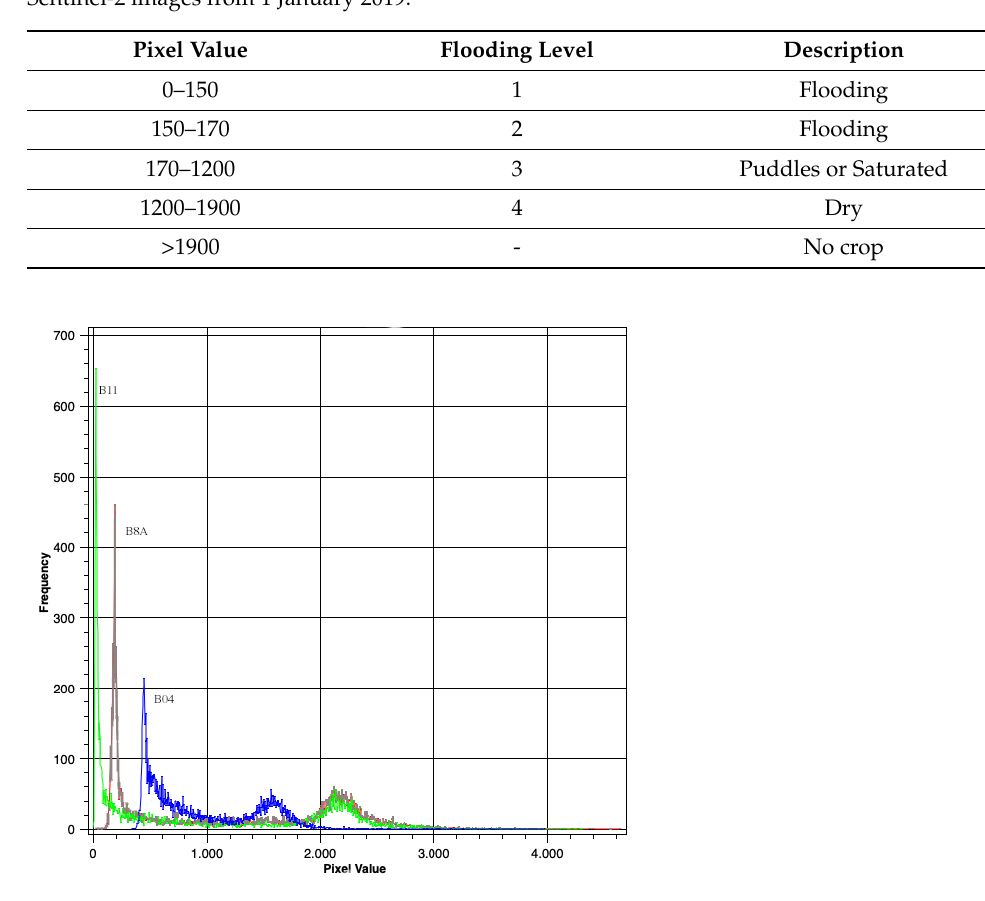
Figure 3. Pixel values of bands B8A, B11, and B04 of paddy fields in Valencia obtained from 1 January 2019 from Sentinel-2 multispectral images.